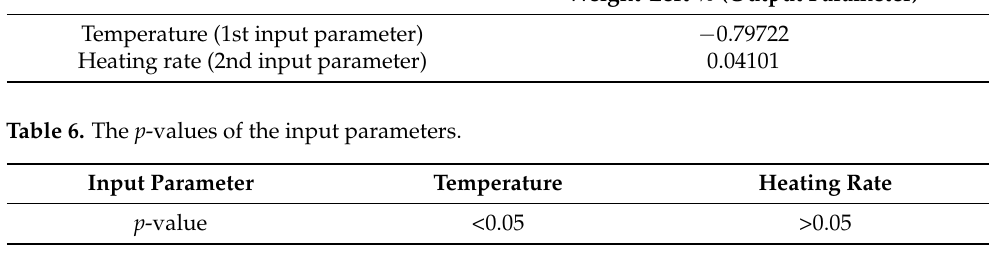
Table 5. The correlation values between the input and output parameters.